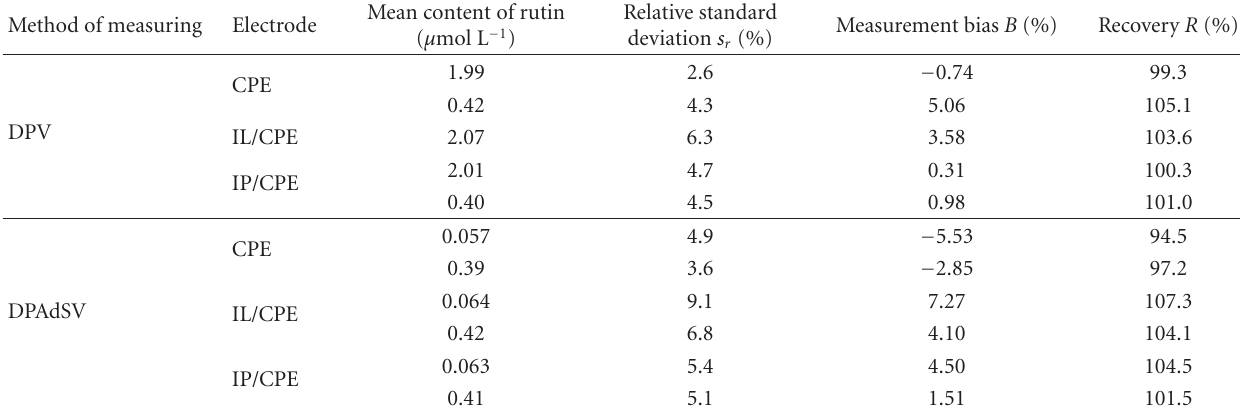
Figure 8: Pulse amperograms (the currents flowing during cleaning step are removed from the amperograms) and corresponding calibration curves of rutin on unmodified (a), iron phthalocyanine modified (b) and ionic liquid modified (c) CPE. The potential was set to +600mV for 60 s, current was sampled at this point. A 30 s cleaning step at –300mV followed, during which aliquots of rutin sample solution were introduced into the measuring cell. Table 4: DPV and DPAdSV determination of rutin in model samples using the method of standard additions. Number of repeated measurements n =